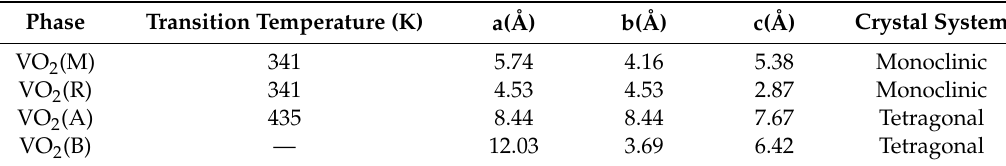
Table 1. The crystal data of VO 2